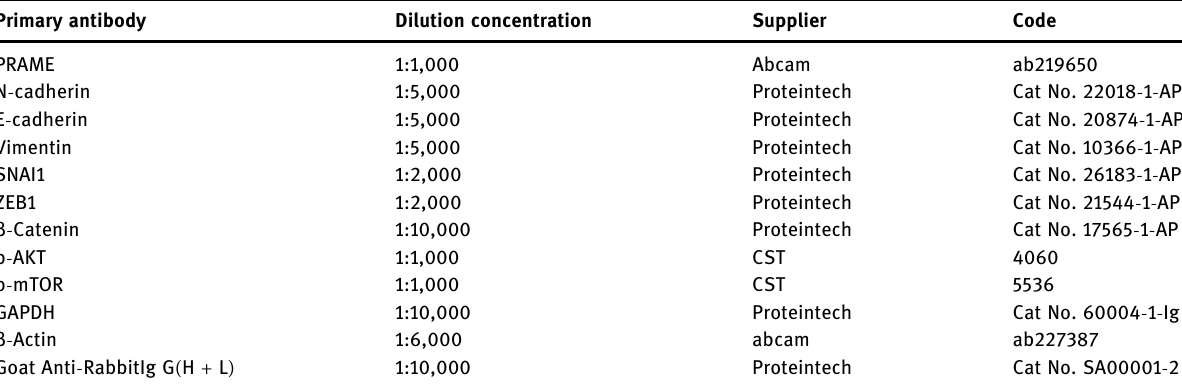
Table 3: The information for primary antibodies used in western blot analysis Primary antibody